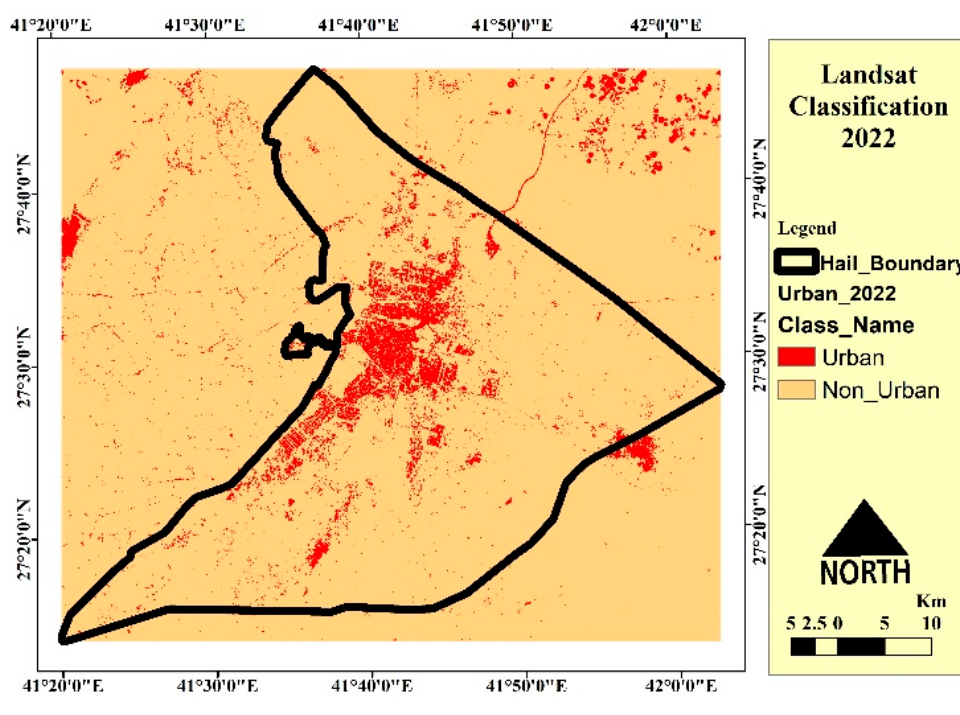
Figure 8. Landsat classification for an urban area, 2022.